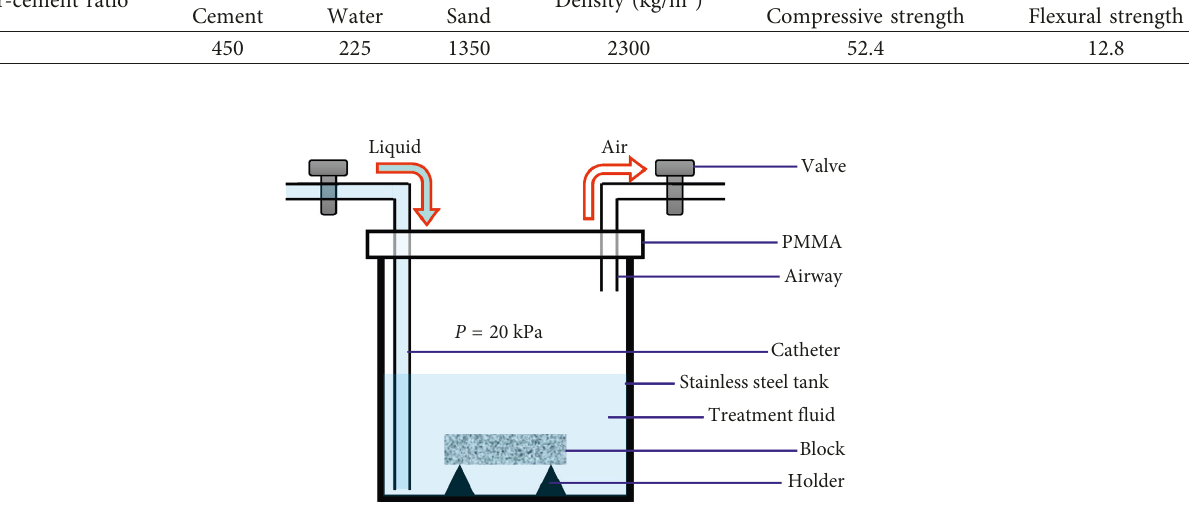
Figure 1: Schematic of osmosis vacuum degassing device.